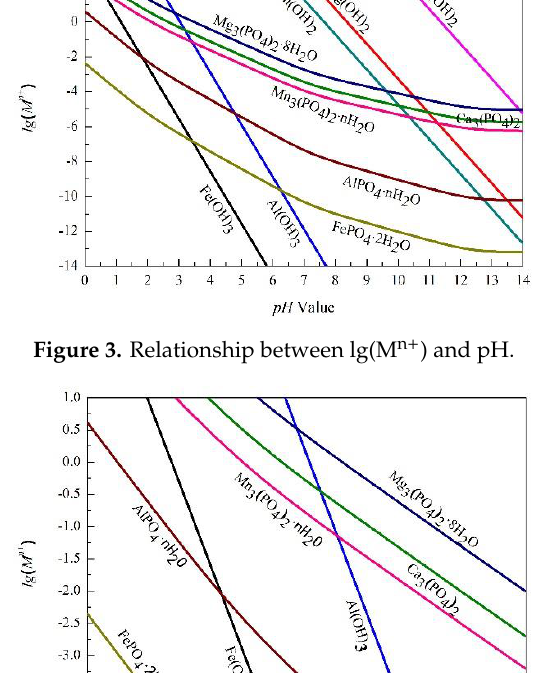
Table 4. Critical pH of each phosphate and hydroxide precipitation in the reaction system.